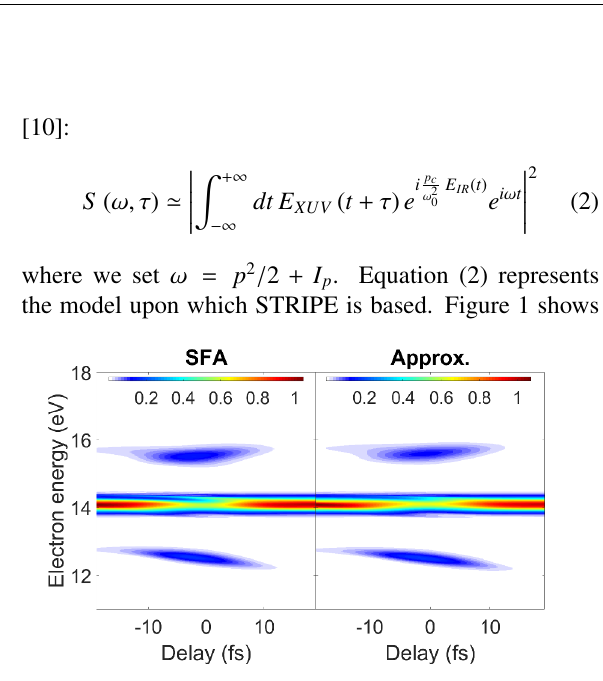
Figure 1. Comparison of a single-harmonic phototelectron trace, computed with the SFA formula (left) and the STRIPE model (right). The agreement is very good as the STRIPE model can de- scribe all the features of the main band and the sidebands. How- ever, the computational e ff ort for computing the trace with the simplified model is significantly smaller than the one needed for the SFA calculations.